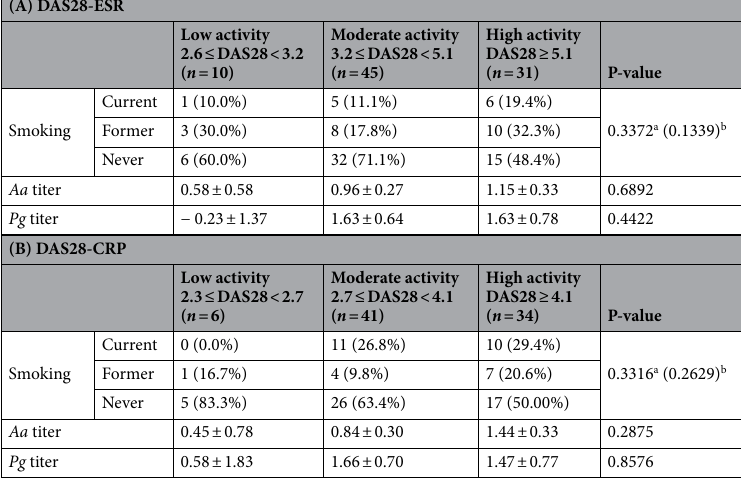
Table 4. Serum IgG antibody titers by disease activity. Data are expressed as means ± SE. Aa Aggregatibacter actinomycetemcomitans , CRP C-reactive protein, DAS28 disease activity score 28, ESR erythrocyte sedimentation rate, IgG immunoglobulin G, Pg Porphyromonas gingivalis , SE standard error. There were no significant differences between the disease activities (P-value: one-way analysis of variance). Effect of smoking was tested using Fisher’s exact test for "a" and "b". a Comparison between each value (3 × 3 Fisher’s exact test). b Comparison between "current + former" vs "never.” (2 × 3 Fisher’s exact